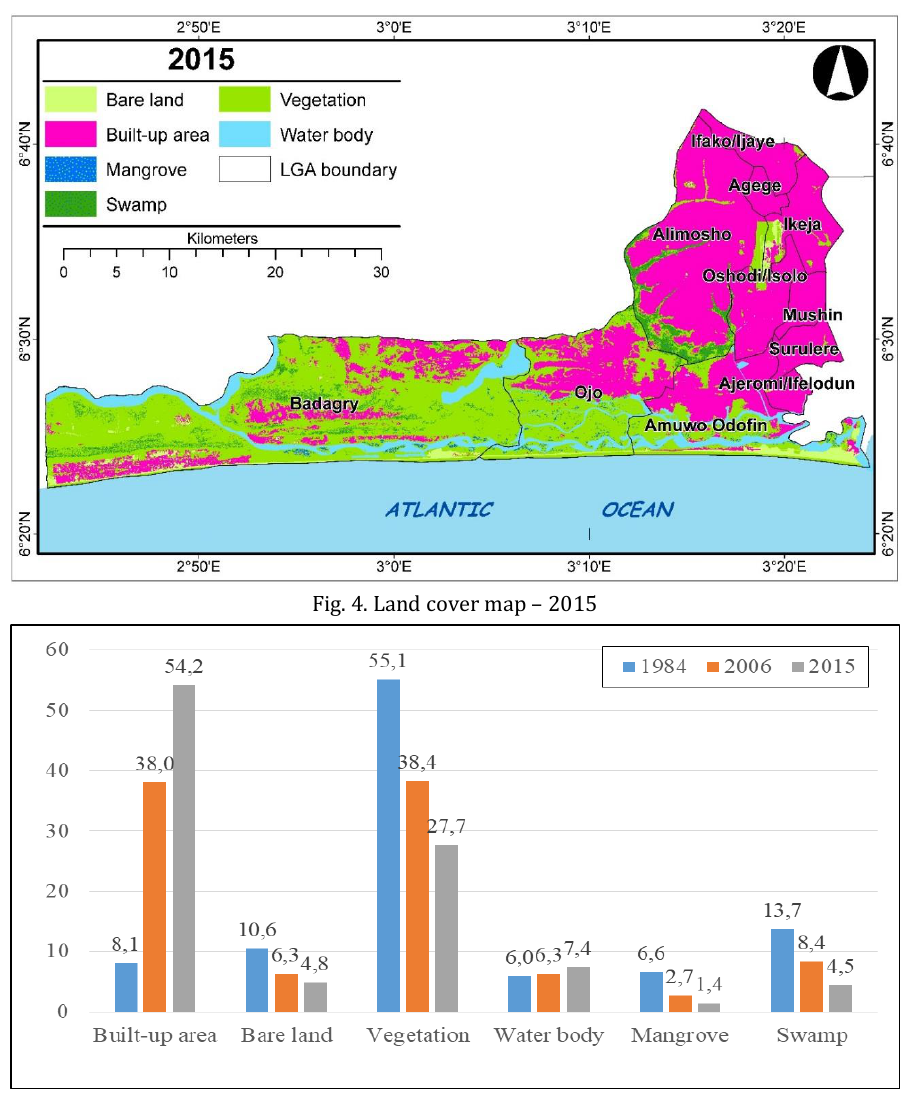
Fig. 5. Percentage distribution of land cover – 1984, 2006 and